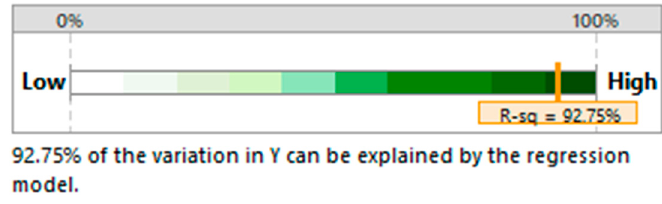
Figure 7. Statistic R 2 (% of variation explained by the Figure 5. Statistic R 2 (% of variation explained by the model). Figure 5. Statistic R 2 (% of variation explained by the model). Figure 5. Statistic R 2 (% of variation explained by the model).